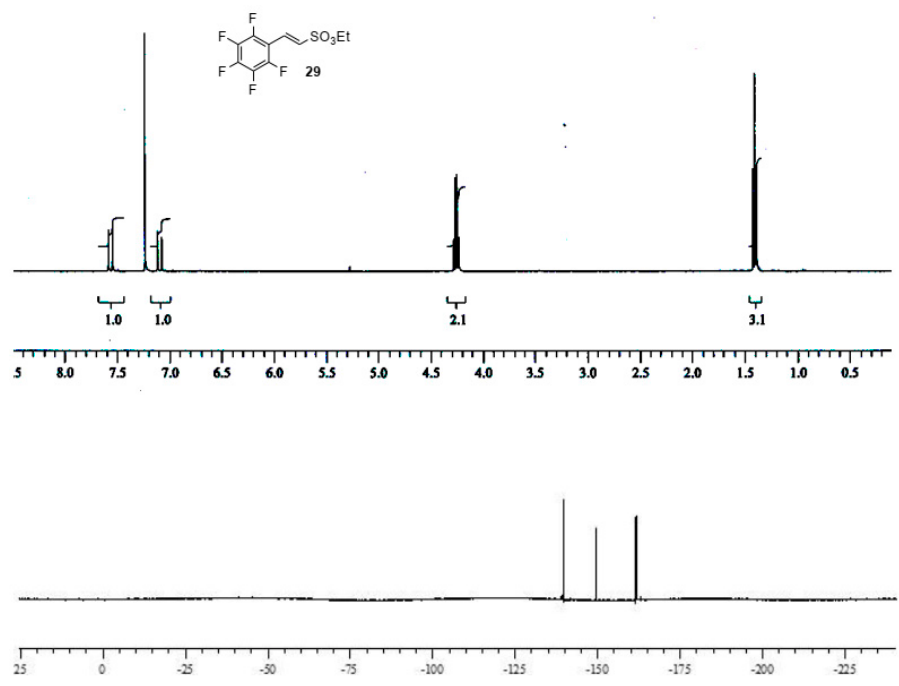
Figure 3. 1 H- and 19 F-NMR spectra images of (E)-ethyl 2-(perfluorophenyl)ethenesulfonate 29 .